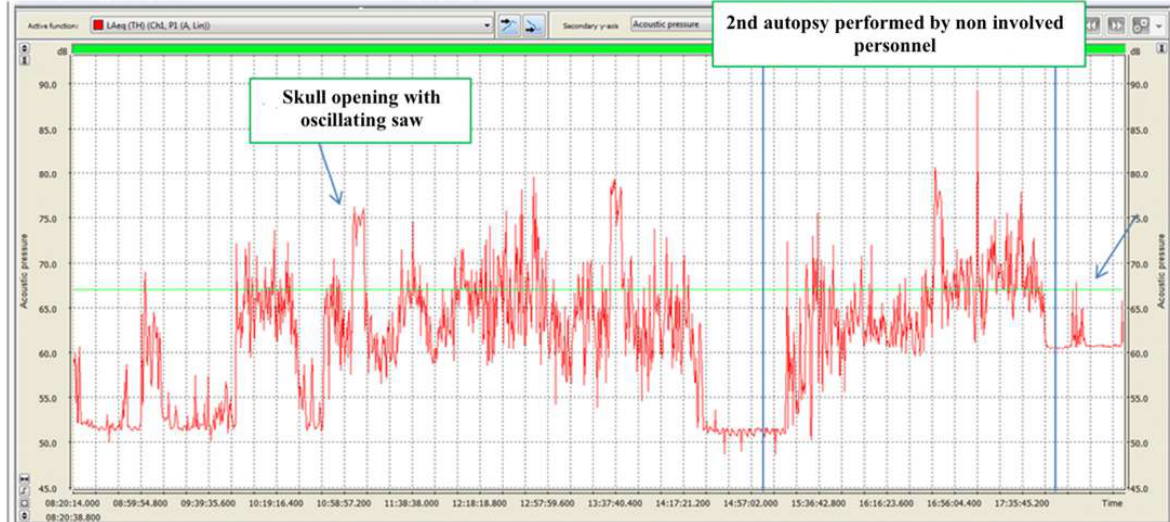
Figure 5. 07.10.2016. Acoustic emissions during autopsy. Red line: equivalent sound level during T period of 15” (Leg), expressed as dB (A). Green line: equivalent sound level during the entire monitoring period (Leg), expressed as dB (A).